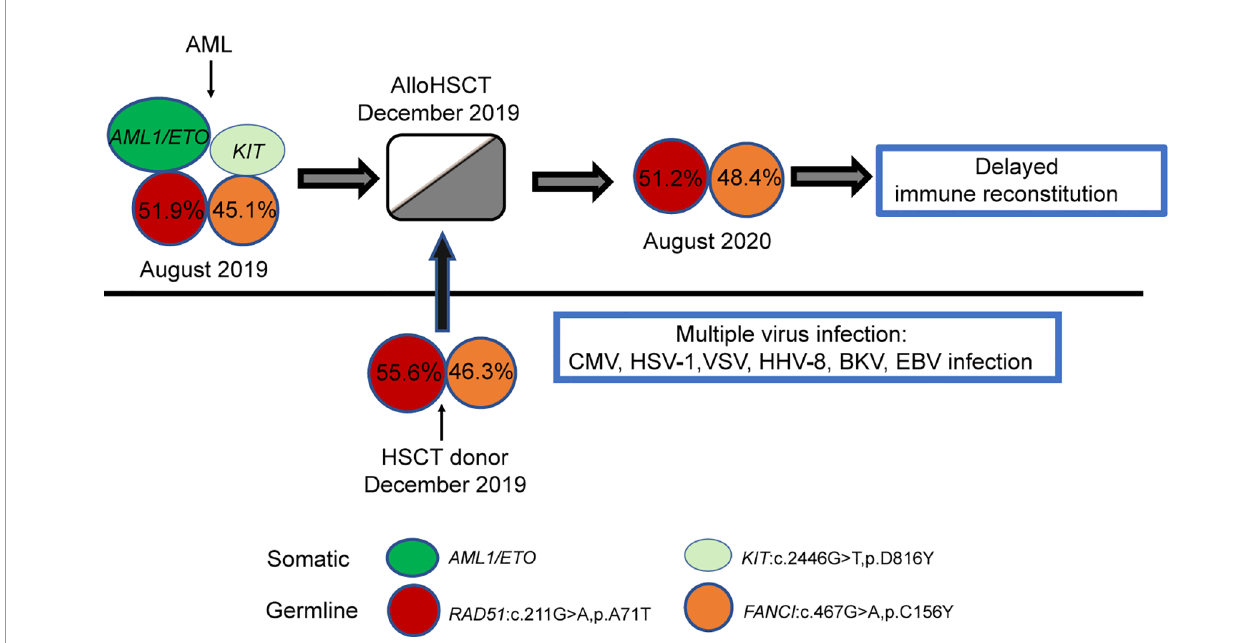
FIGURE 3 | Model depicting the role of germline mutations in the FANCI and RAD51 genes in the case. Each coloured circle represents a speci fi c mutation, and the numbers depicted show the variant allele frequency. Variant allele frequency was obtained through the proportion of variant reads for a particular sequence.